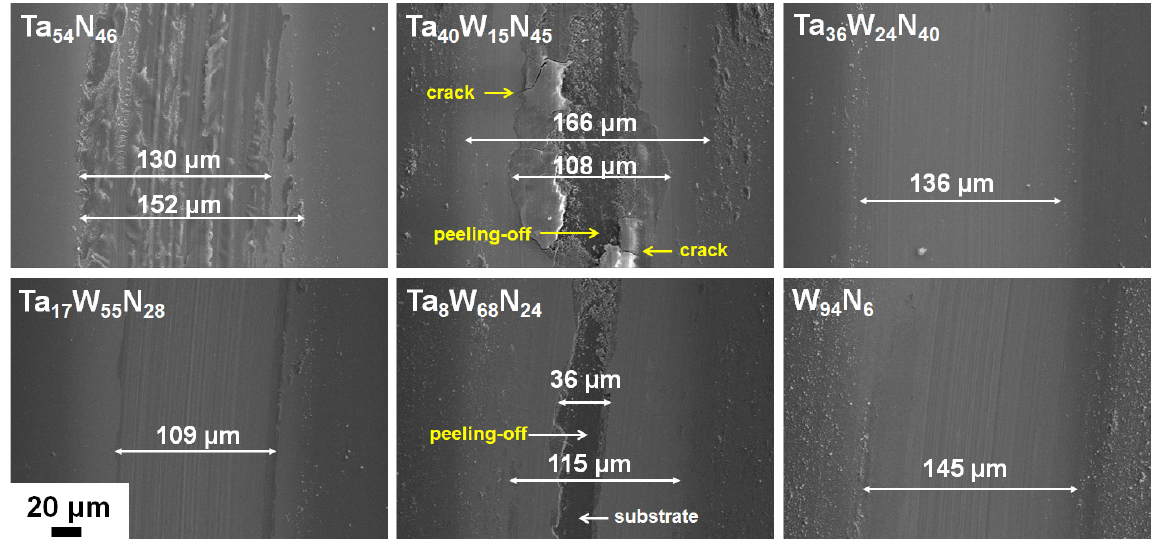
Figure 10. Wear scars of the TaWN/Ta/SUS420 samples after sliding for 50 m.